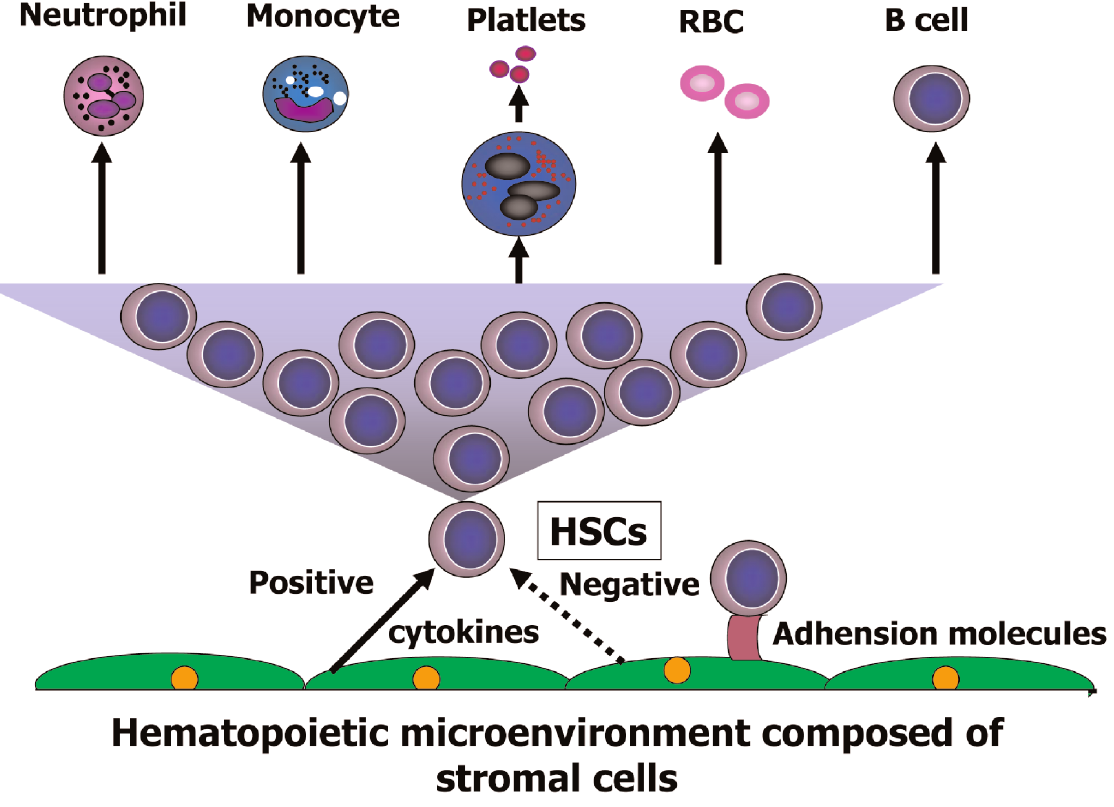
Figure 1. Hematopoietic tissues. Hematopoietic tissues are composed of hematopoietic cells and non-hematopoi- etic cells, which are referred to as the hematopoietic microenvironment. The hematopoietic microenvironment is composed of stromal cells that regulate the proliferation and differentiation of hematopoietic stem cells (HSCs) by producing cytokines that act as positive and negative regulators and through direct cellular interactions with adhesion